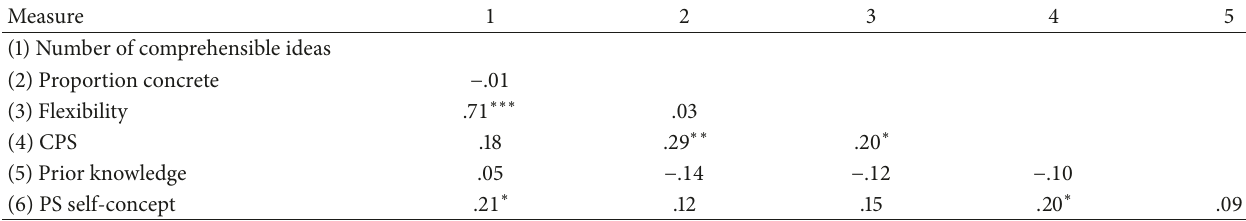
Table 2: Pearson’s correlations between